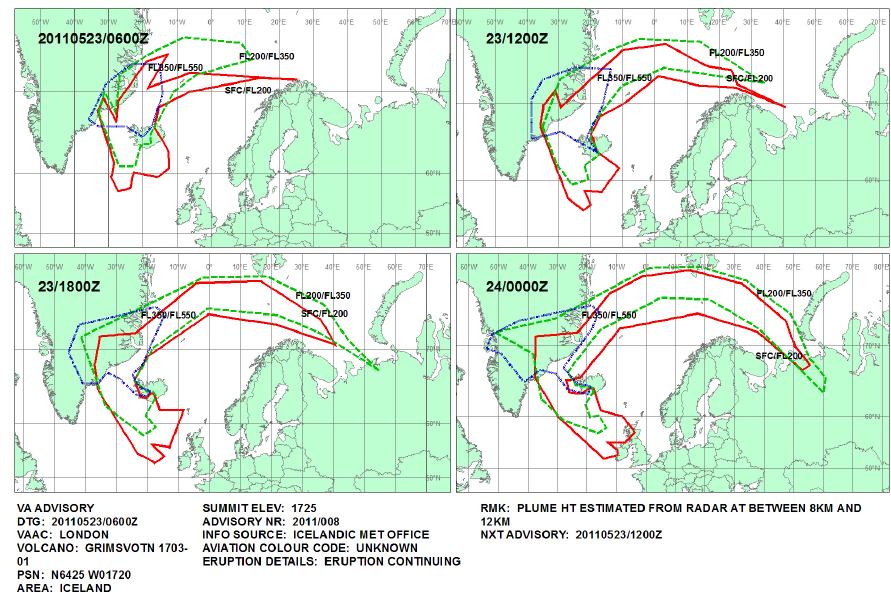
Figure 14. Volcanic ash graphic (VAG) issued by the London VAAC on 23 May 2011 at 06:00UTC. The forecast is valid for the following 18h in 6h intervals and shows forecast ash regions from the surface to three flight levels: FL200 (20000ft or 6096m, in red), FL350 (35000ft or 10668m, in green dashes), and FL550 (55000ft or 16764m, in blue